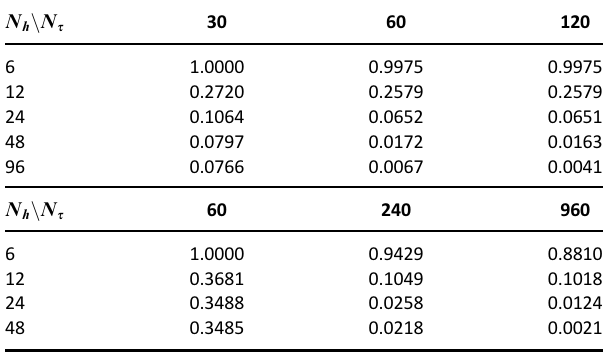
Table 5. (Time space convergence of lift with volume forcing, cf. section Convergence tests ) The approximation error e p 1 hNh ; s N s scaled by the inverse of e p 1 ¼ 9 : 7149 (cid:4) 10 (cid:3) 2 for linear ansatz h 6 ; s 30 functions (top) and e p 1 scaled by the inverse of e p 2 ¼ hNh ; s N s h 6 ; s 60 5 : 288 (cid:4) 10 (cid:3) 3 for quadratic ansatz functions (bottom) with ρ ref explicitly given for varying space and time discretizations for Test Case 1.